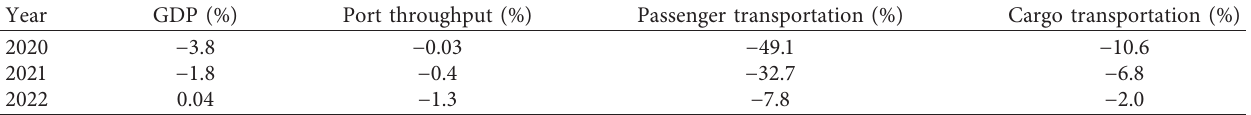
Table 8: The impact on the main variables when COVID-19 epidemic is